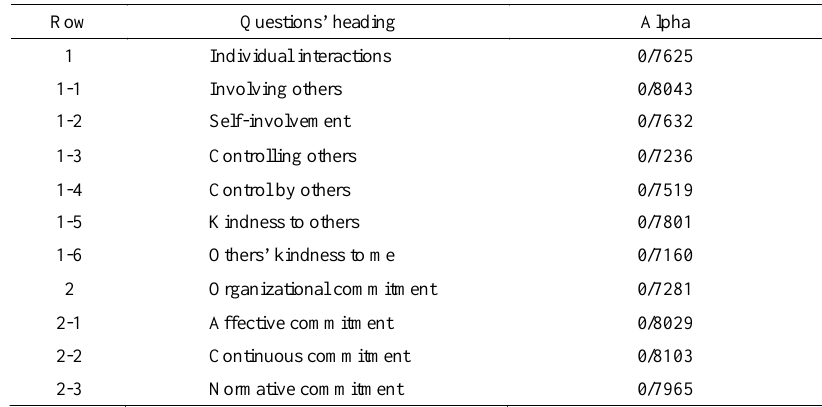
Table 3: Cronbach’s alpha coefficients of the